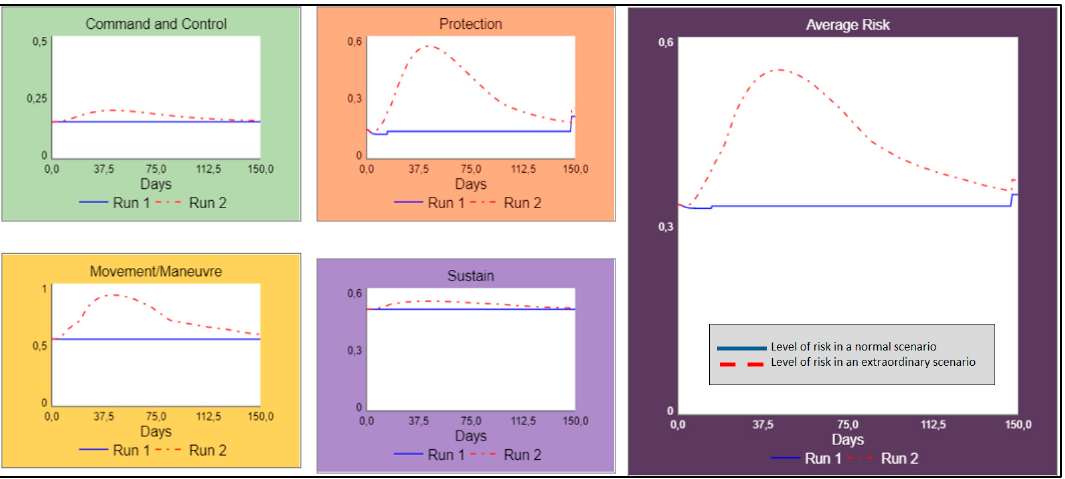
Figure 8. Sample output graph of risk assessment functions for baseline (normal) and extraordinary scenarios.